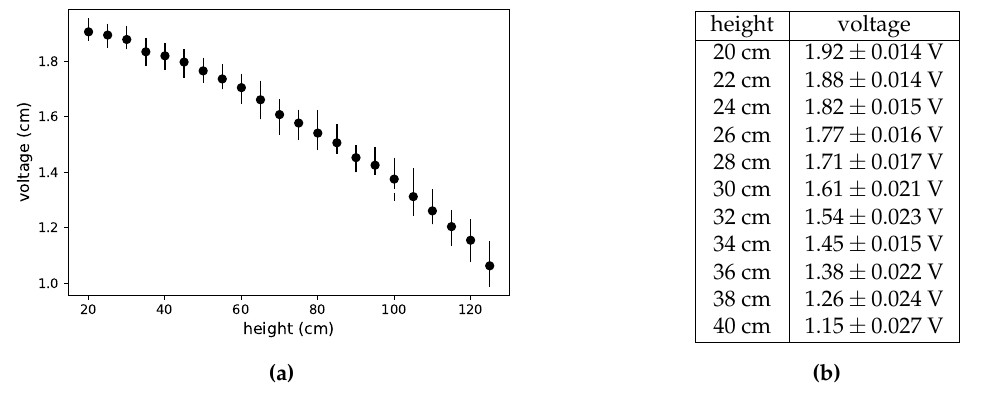
Figure 2. ( a ) Plot of measured voltage vs. distance, and ( b ) measured voltage ranges for some